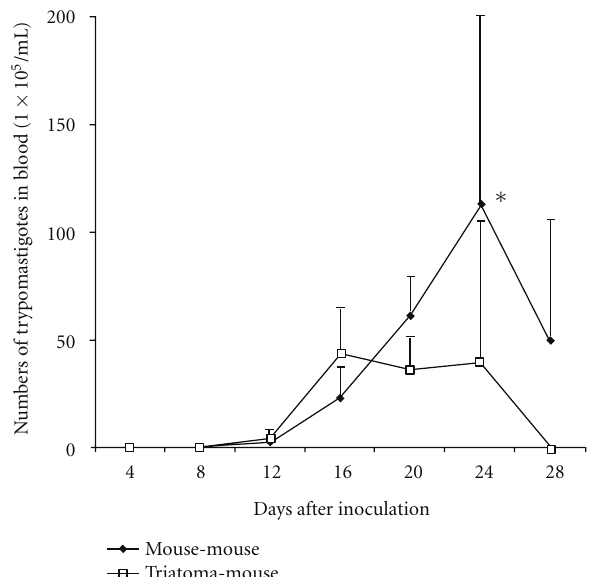
Figure 1: Parasitemia curve of H4 strain (mouse-mouse) versus (triatoma-mouse). ( ∗ P value < 0.05 in comparison with all evaluated groups).